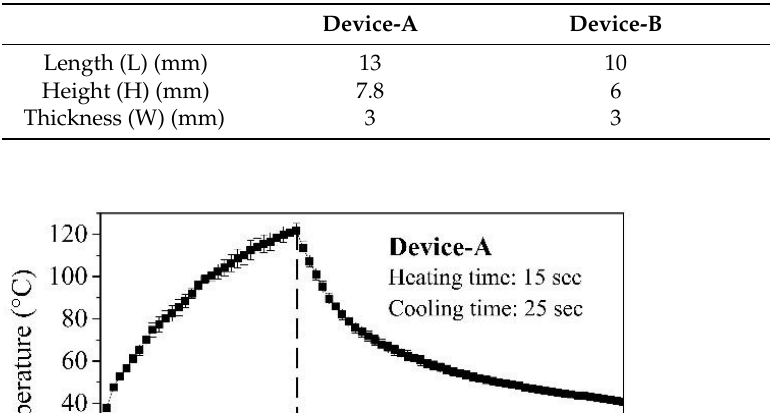
Table 2. The dimensions of the LCE devices for locomotion measurement.